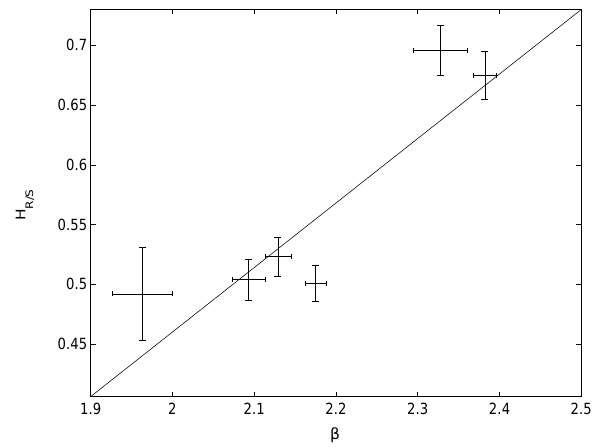
Fig. 5. Plot of H R/S (from range scaling analysis) versus β (from power spectral analysis). The best-fit linear curve is indicated as the solid line. The straight line represents H R/S = ( 0 . 54 ± 0 . 13 )β − ( 0 . 62 ± 0 . 29 )